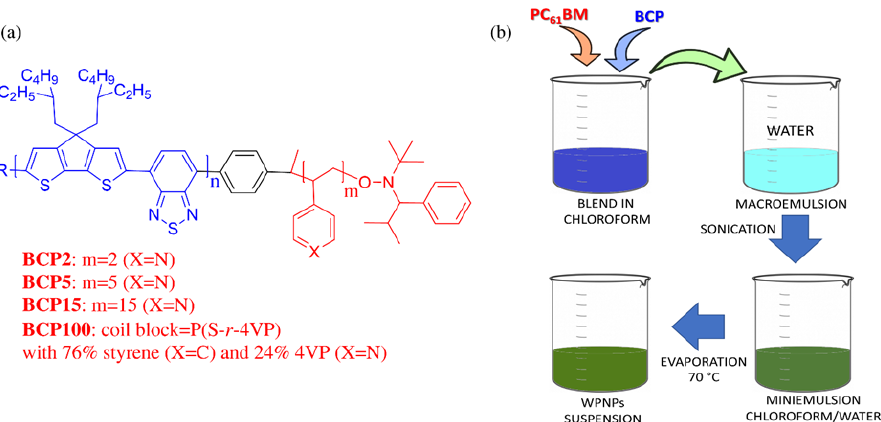
Figure 1. ( a ) Molecular structures of the amphiphilic rod – coil block copolymers (BCPs) used in this work; ( b ) preparation of the blended water-processable nanoparticles (bWPNPs) through the adapted miniemulsion approach as used in this work.